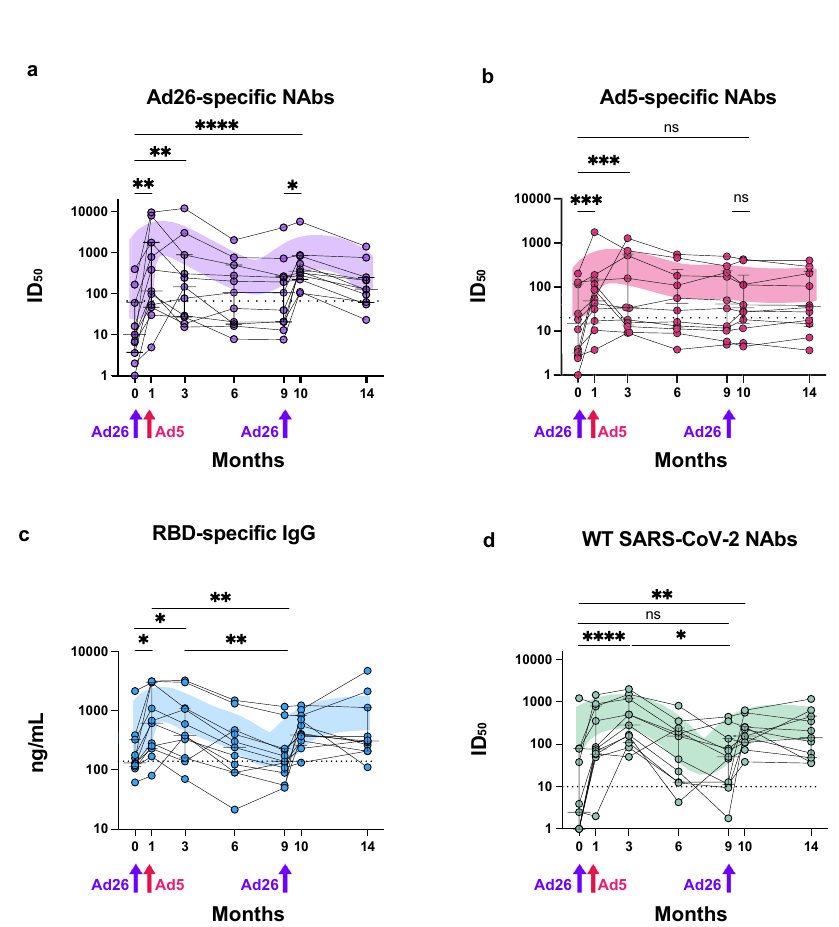
Fig. 3 Longitudinal analysis of humoral responses to Gam-COVID-Vac vaccination. Ad26-speci fi c NAb ( a ), Ad5-speci fi c NAb ( b ), anti-RBD IgG ( c ), and WT SARS-CoV-2 NAb ( d ) responses before the fi rst dose of Gam-COVID-Vac and up to 14 months later. LOWESS-smoothed lines are shown. Arrows indicate immunization timepoints. Asterisks indicate signi fi cant difference between groups determined using the Friedman